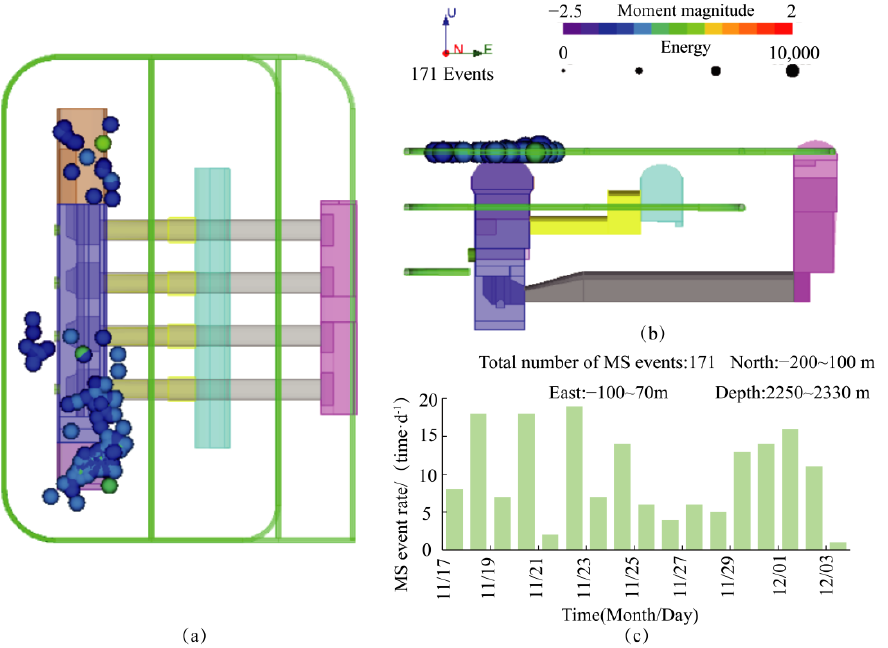
Figure 10. Spatial and temporal evolutions of the MS events from 17 November to 3 December 2018. ( a ), Top view of MS event distribution; ( b ), Side view of MS event distribution; ( c ), The activity rate of the daily MS events.